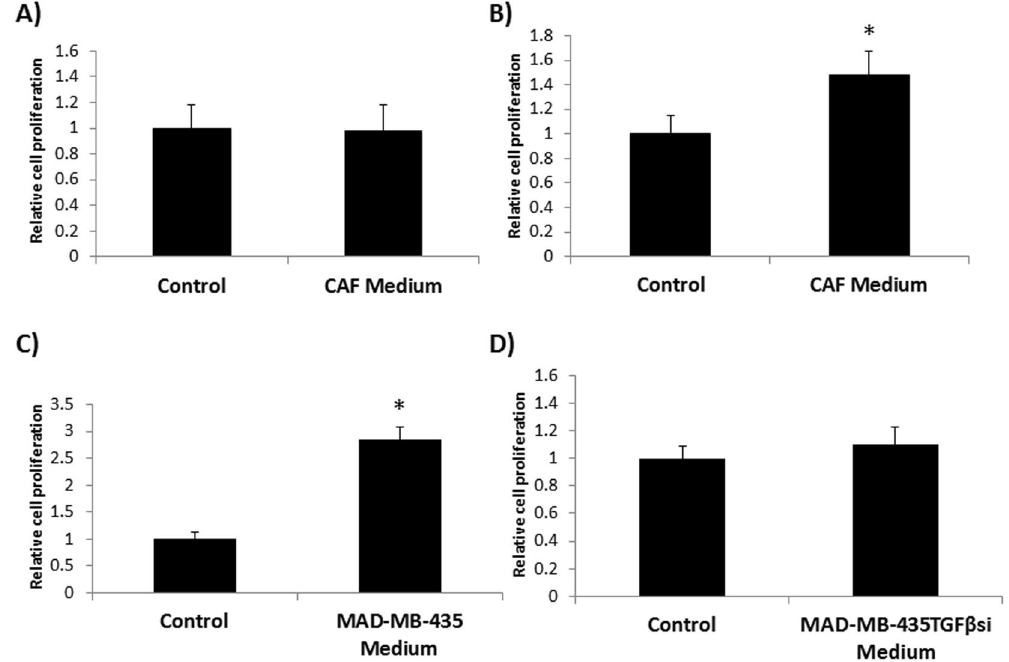
Figure 3. Co-culture assay to determine effects of paracrine signaling from tumor cells and CAFs. MDA-MB-435 (A ) and MDA-MB-435TGF β si (B) cells were cultured in CAF conditioned-medium for 72 hrs and then analyzed for proliferation using MTT assay. Similarly, CAFs were also cultured in conditioned medium from either MDA-MB-435 (C) or MDA-MB-435TGF β si (D) cells for 72 hrs and changes were determined by MTT assay. * p <